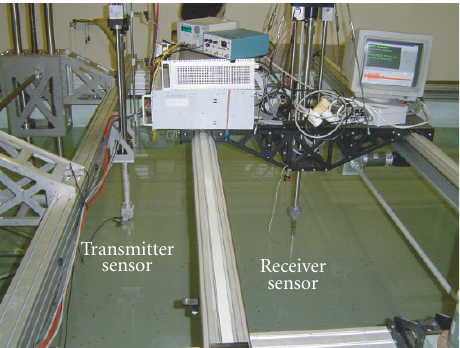
Figure 2: Experimental tank. Figure 3: Experimental setup.